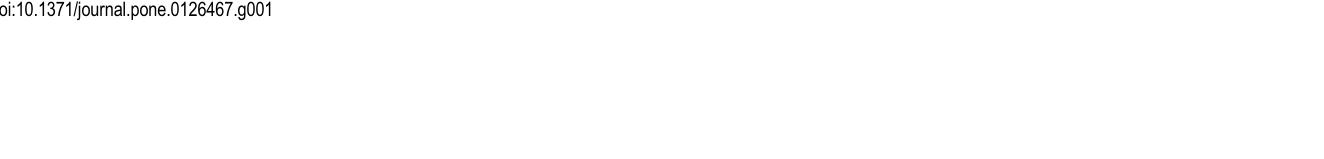
Fig 1. The methodology ’ s architecture. ( A ) The Computational Paradigm's and its comprising components. ( B ) The Computational Paradigm ’ s design of its processing modules and information